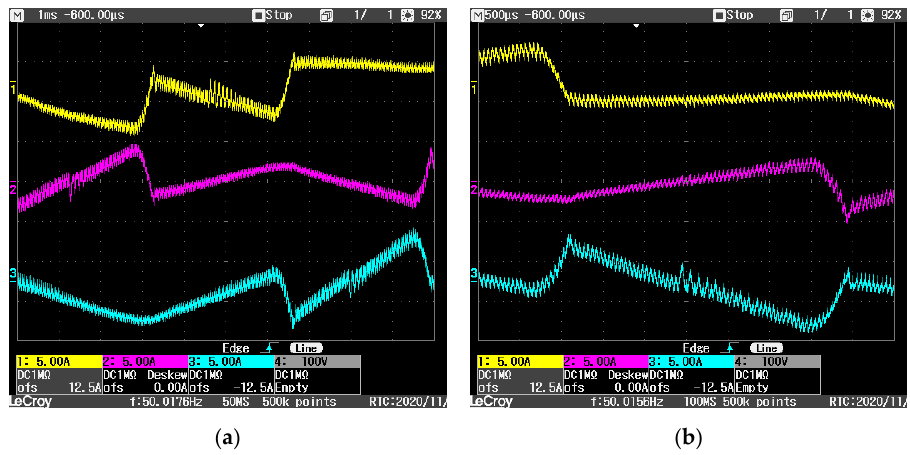
Figure 19. Details of SAPF phase current waveforms at 1 ms/div ( a ) and 500 µs/div ( b ).